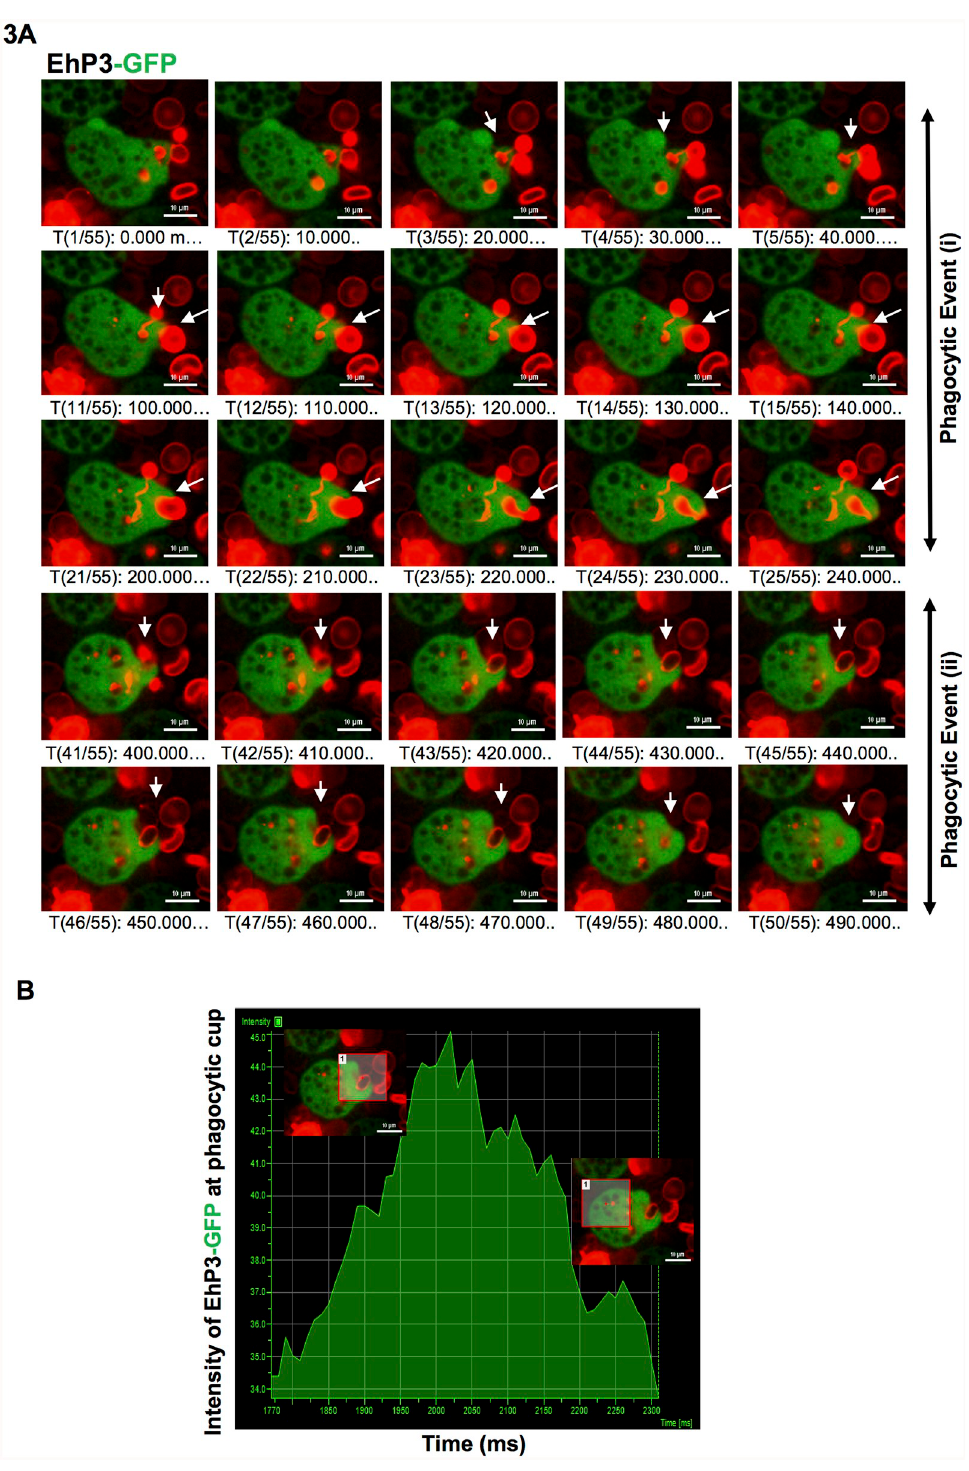
Fig 3. Time-lapse imaging of GFP-EhP3 during phagocytosis of red blood cells (RBCs). (A) The montage shows time- lapse images of an amoeba cell expressing GFP-EhP3 undergoing phagocytosis of RBCs. RBCs were stained with DiD dye. Represented images are from two different phagocytic events showing de novo formation of a phagocytic cup, closure of cup and formation of phagosome, marked by white arrow heads. GFP-EhP3 accumulated rapidly at the site of attachment of RBC and remained till the formation of phagosome. (Scale bar, 10 μ m). (B) The graph represents intensity profile of GFP-EhP3 at selected ROI in phagocytic cup vs. cytoplasm during